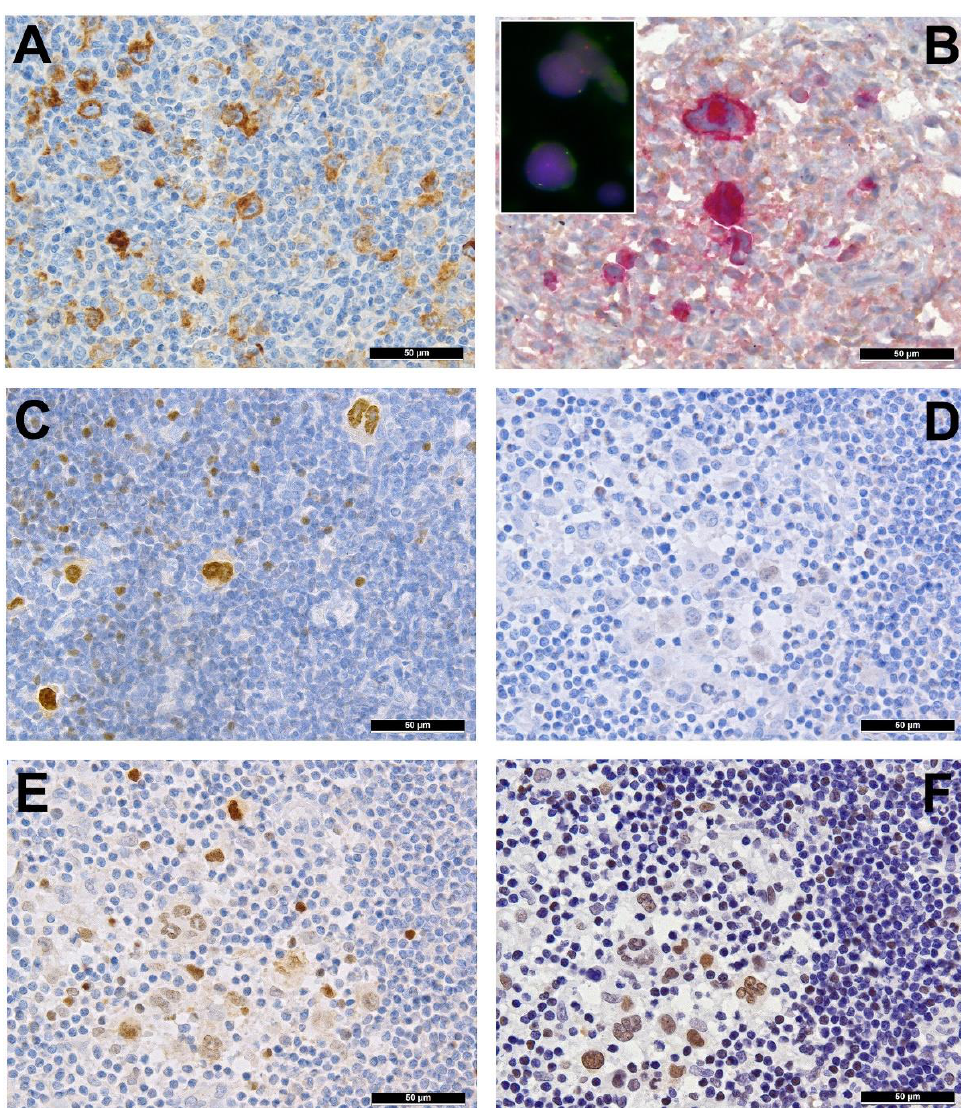
Figure 2 . ( A ) PDL1 overexpressing Hodgkin and Reed-Sternberg (HRS) cells in a case of PDL1/2 amplified classic Hodgkin lymphoma (cHL). ( B ) HRS cells expressing phosphorylated (p) JAK2 in a JAK2 rearranged cHL (insert with split red and green FISH signals corresponding to the rearranged allele and one fused yellow signal corresponding to the wild type allele of the JAK2 gene in the respective large HRS cell-equivalents utilizing a break-apart JAK2 probe). ( C ) pSTAT6 overexpressing HRS cells in a case of STAT6 -mutated cHL. ( D ) Expression of pSTAT6 only in a few HRS cells as compared to. ( E ) pSTAT5 and, particularly, pSTAT3. ( F ) in a case of SOCS1 -mutated cHL.